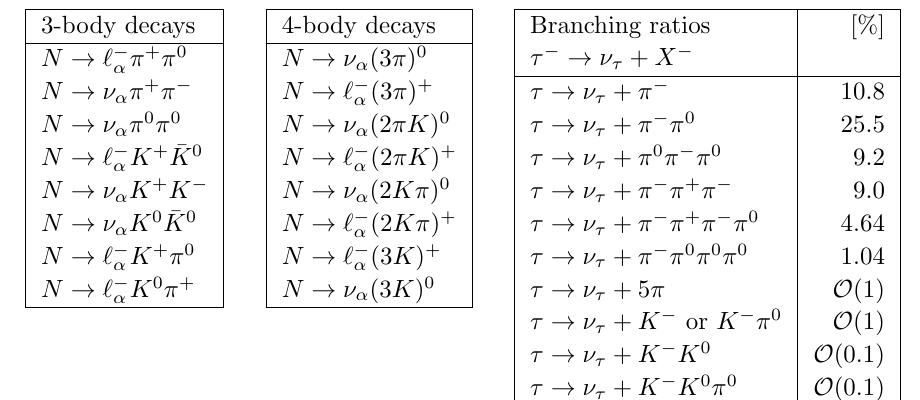
Figure 16 . HNL decay widths into all relevant single meson channels, divided by the total decay width into quarks with QCD corrections, estimated as in (3.11) (all dashed lines). The blue solid line is the sum of the all mesons divided by decay width into quarks with QCD corrections, blue dotted line is the same but without QCD corrections.